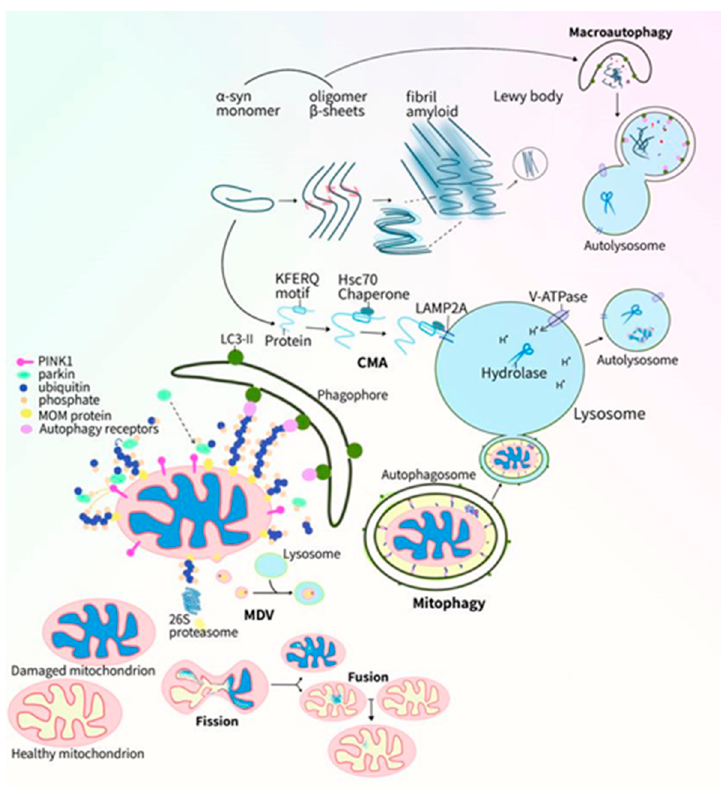
Figure 1. The importance of mitochondrial dysfunction, α -syn aggregation, and the autophagy-endo-lysosomal system dysregulation in PD (Parkinson’s disease) pathogenesis. The clearance of damaged mitochondria and denatured α -synuclein ( α -syn) are through autophagy-lysosome pathways. Minor mitochondrial damage is fixed via dynamic fission and fusion, complementing the damaged organelles and mitochondrial proteins. Medium amounts of damaged mitochondrial proteins and